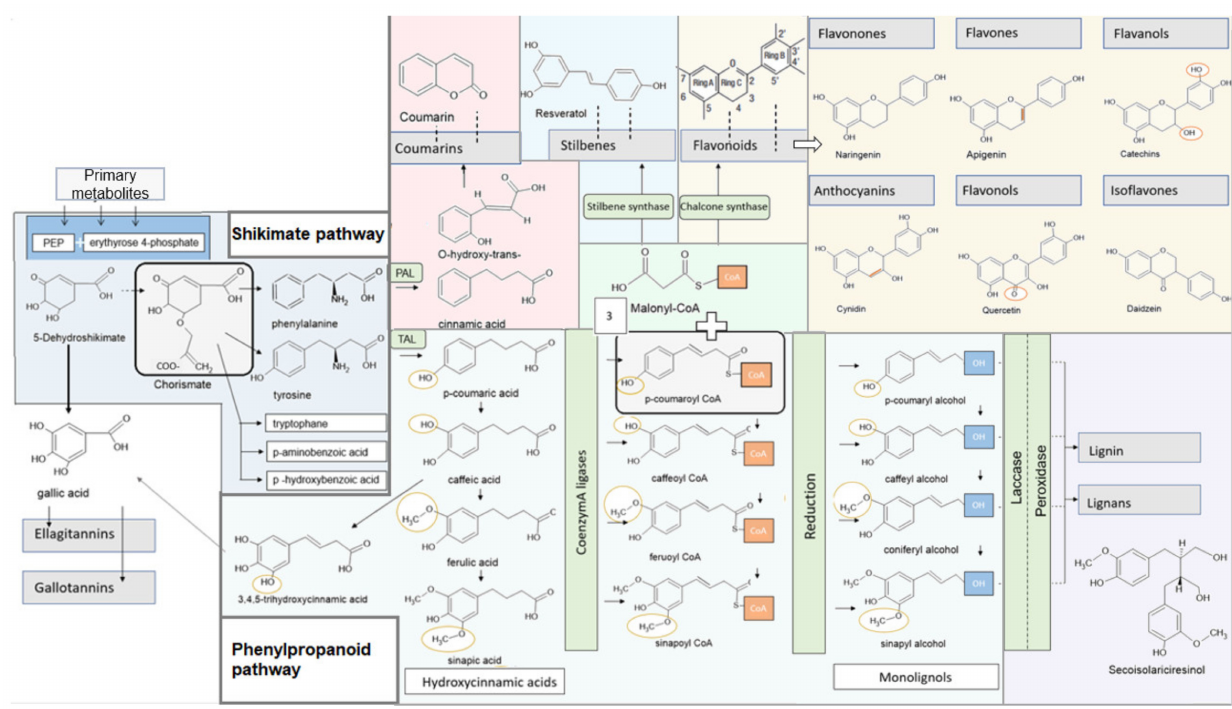
Figure 1. Illustration of phenylpropanoids synthesis and the synthesis of various